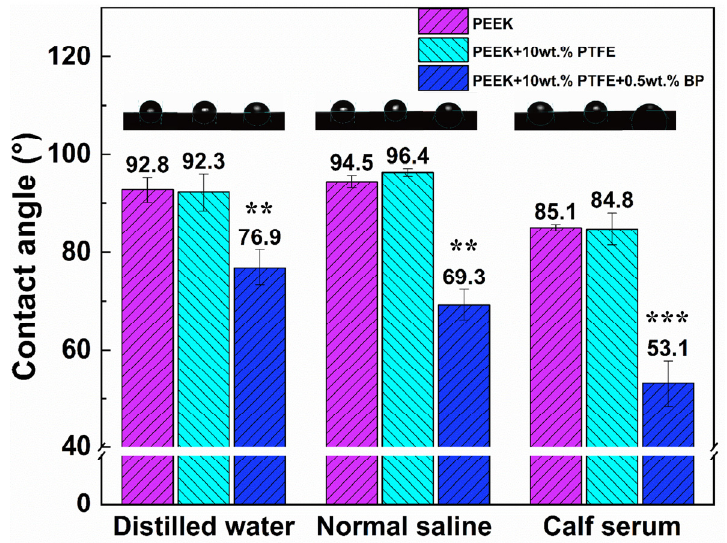
Figure 8. The contact angles of the composites with distilled water, normal saline, and calf serum. (**: p < 0.01, ***: p < 0.001, statistically significant difference; PEEK vs. PEEK/PTFE, PEEK/PTFE/BP).